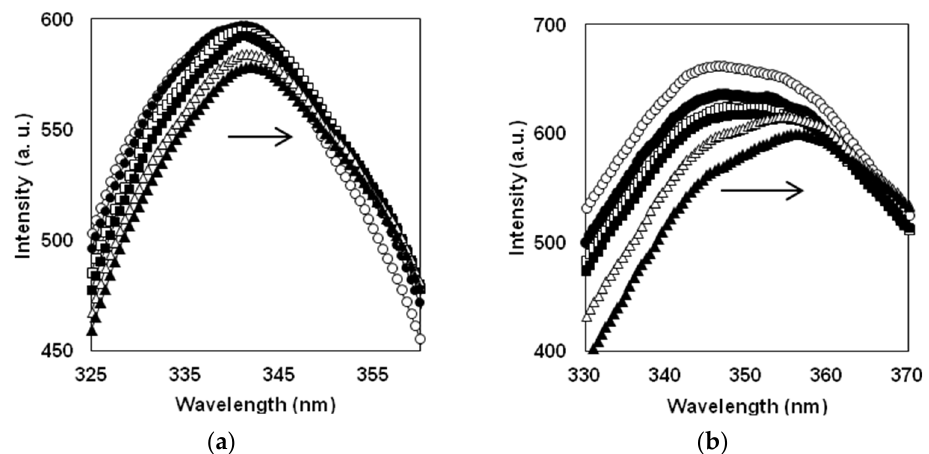
Figure 1. Change in fluorescent spectra in course of proteolysis: ( a ) proteolysis of β -LG (0.25 g/L) by trypsin (0.9 mg/L) at 0 ( ○) , 10 ( ● ), 20 ( □ ), 30 ( ■ ), 40 ( ∆ ), and 50 min ( ▲ ); ( b ) proteolysis of β -CN (0.25 g/L) by trypsin (0.25 mg/L) at 0 ( ○) , 3 ( ● ), 5 ( □ ), 7.5 ( ■ ), 23 ( ∆ ), and 45 min ( ▲ ). Arrows show the direction of the fluorescence shift during proteolysis.